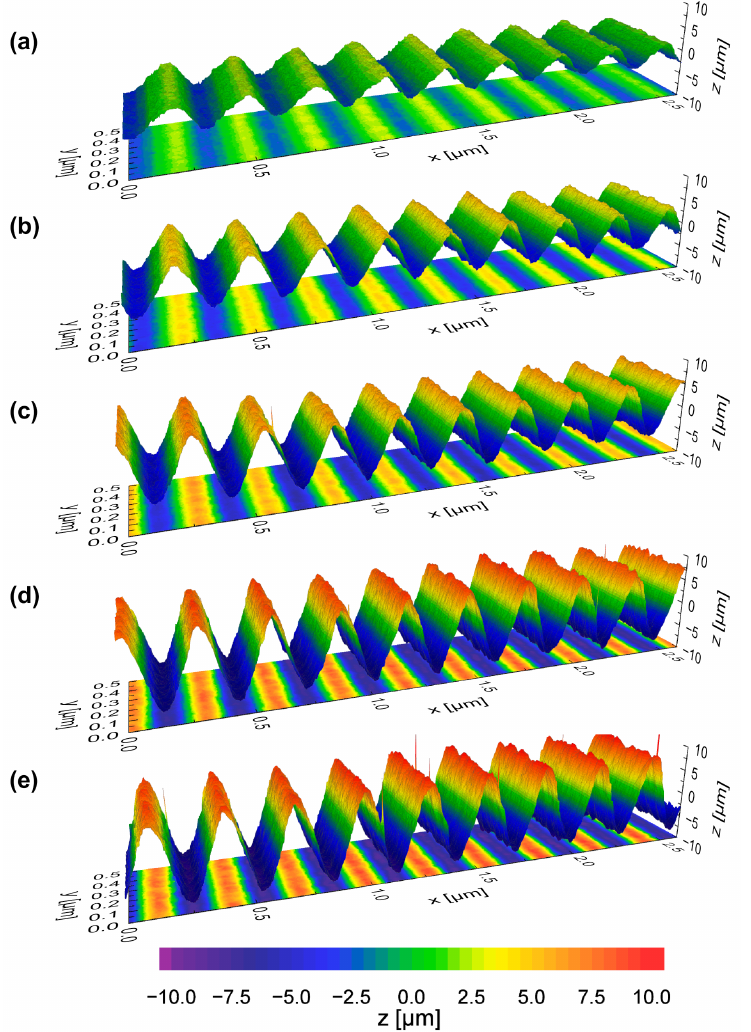
Figure 12. Representative WLI images of surface topographies after areal structuring using ( a ) v scan = 100 mm/s, dy = 12 µ m, n = 1; ( b ) v scan = 200 mm/s, dy = 6 µ m, n = 1; ( c ) v scan = 300 mm/s, dy = 4 µ m, n = 1; ( d ) v scan = 400 mm/s, dy = 3 µ m, n = 1; ( e ) v scan = 500 mm/s, dy = 2.5 µ m, n = 1 ( d L = 50 µ m, t B = const., P M and P A adapted to v scan